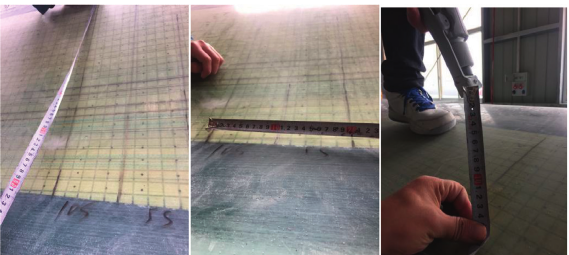
Figure 18: Division of test region.